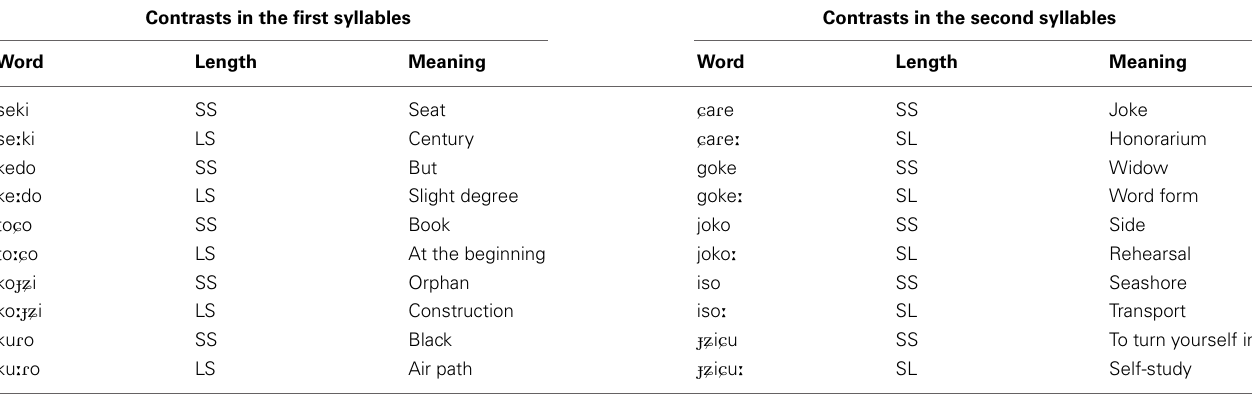
Table 1 | Training